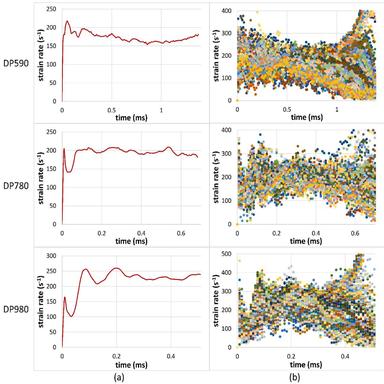
Evolution of (a) AOI-averaged strain rate and (b) strain rate distribution as a function of time for each material.